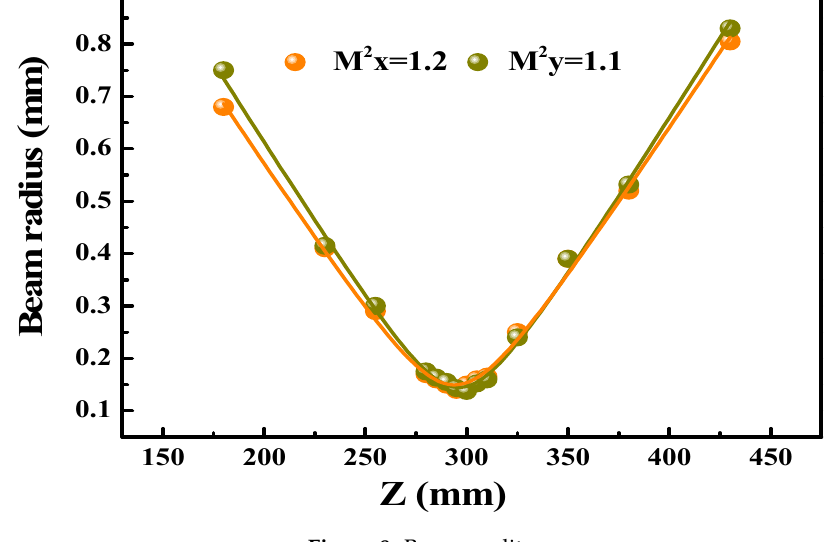
Figure 8. Beam quality.